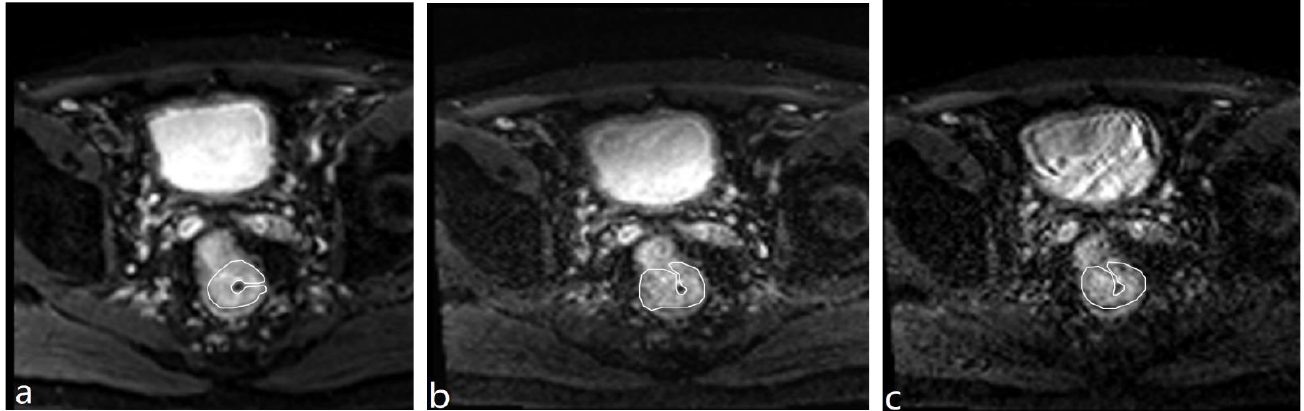
Figure 1. The ROI drawing for cancer lesions on the b = 0 s/mm 2 maps of rs-EPI ( a ); 2 × SMS rs-EPI ( b ), 3 × SMS rs-EPI ( c ).